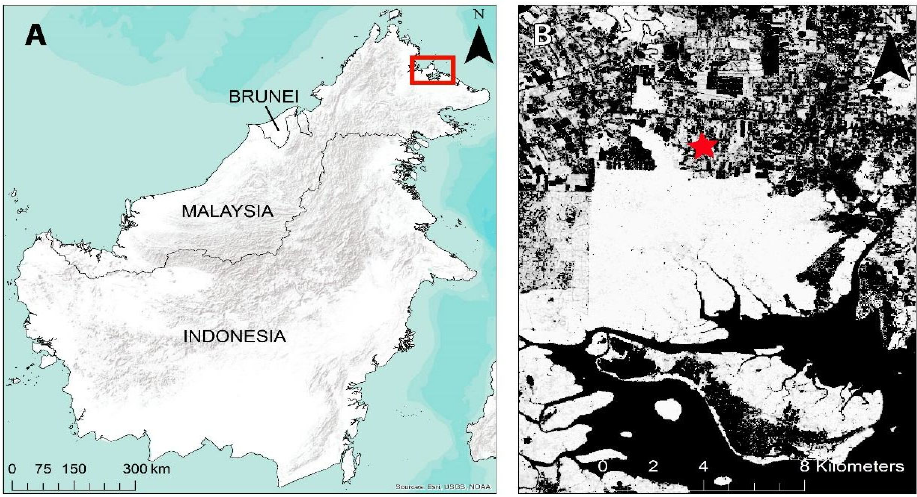
Figure 1. Location of the study site. ( A ) The island of Borneo with the approximate position of the Kabili-Sepilok Forest Reserve (Sabah, Malaysia) highlighted in red. ( B ) The Kabili-Sepilok Forest Reserve with the location of the Forest Research Centre (red star) highlighted. Panel B shows forested areas in white and non-forest areas in black (data from [30]).